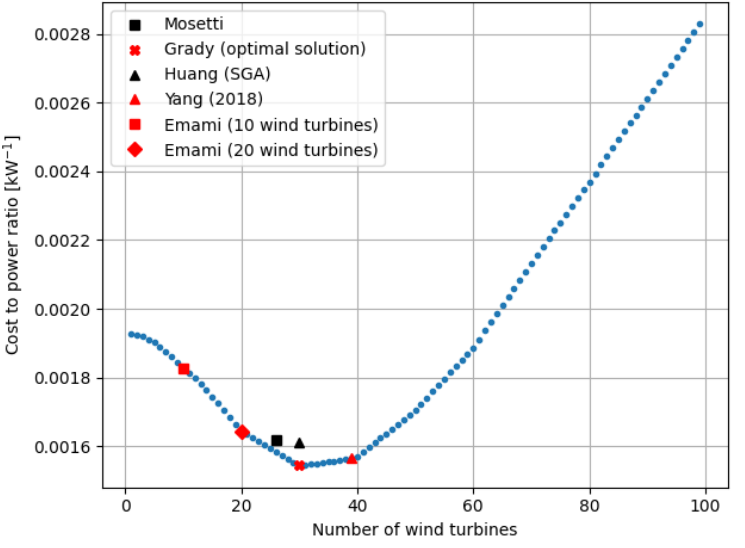
Figure 8. Fitness function values for case 1 for a given number of wind